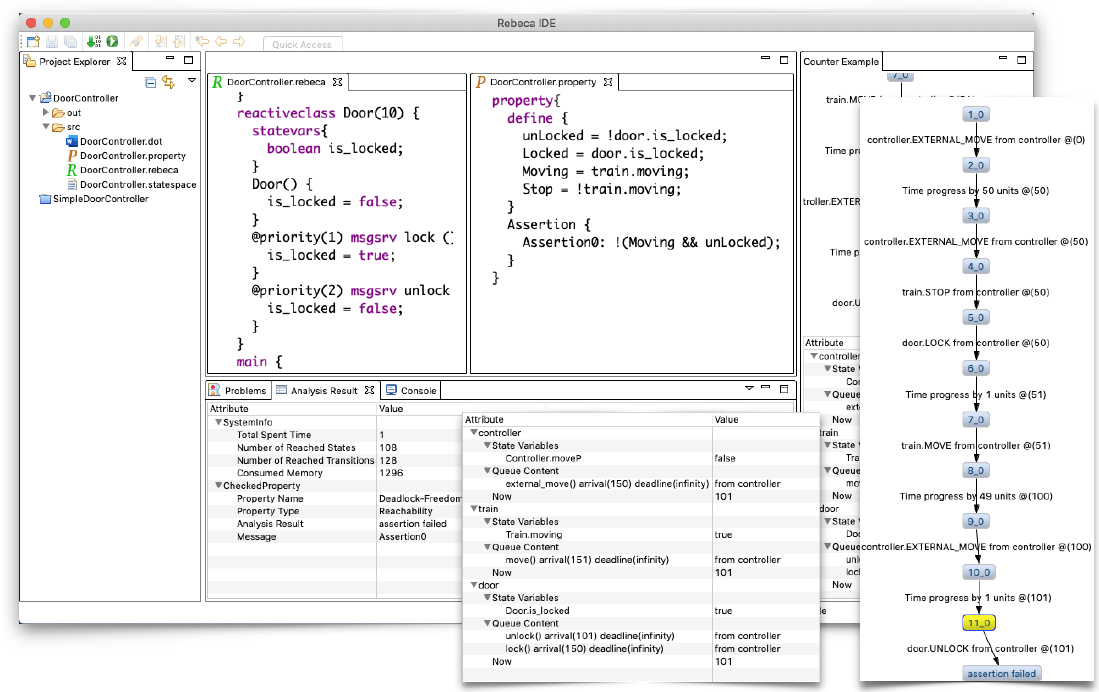
Figure 6. An snapshot of Afra finding the counterexample for the model in Figure 5c where the physical external event occurs every 50 units of time (variable extd in the model is set to 50). The value of the variables and the contents of the message buffer in state 11_0 is shown in the